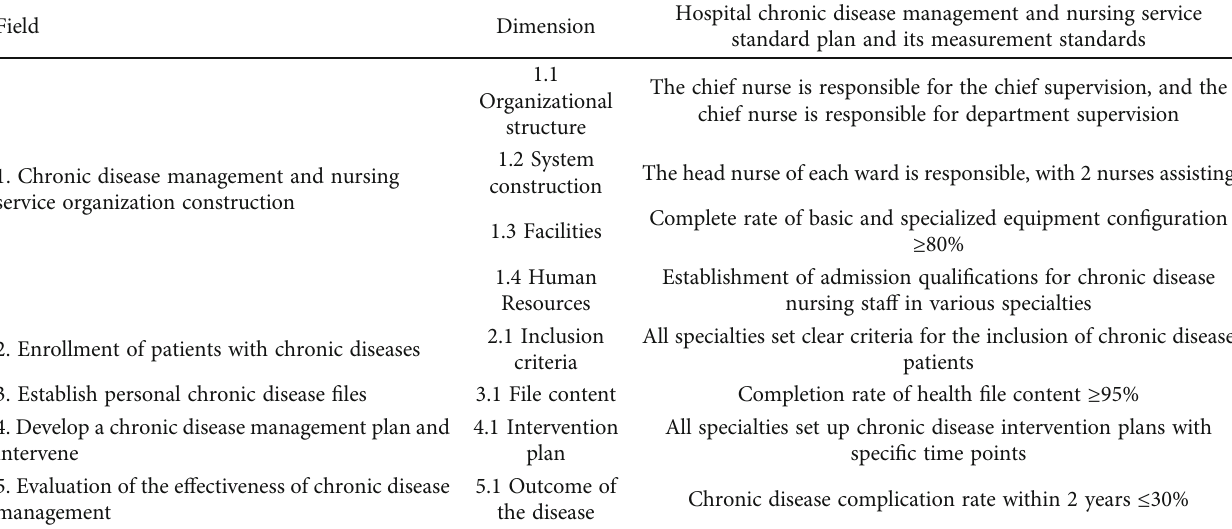
Table 4: Standard plan of hospital chronic disease management and nursing service.